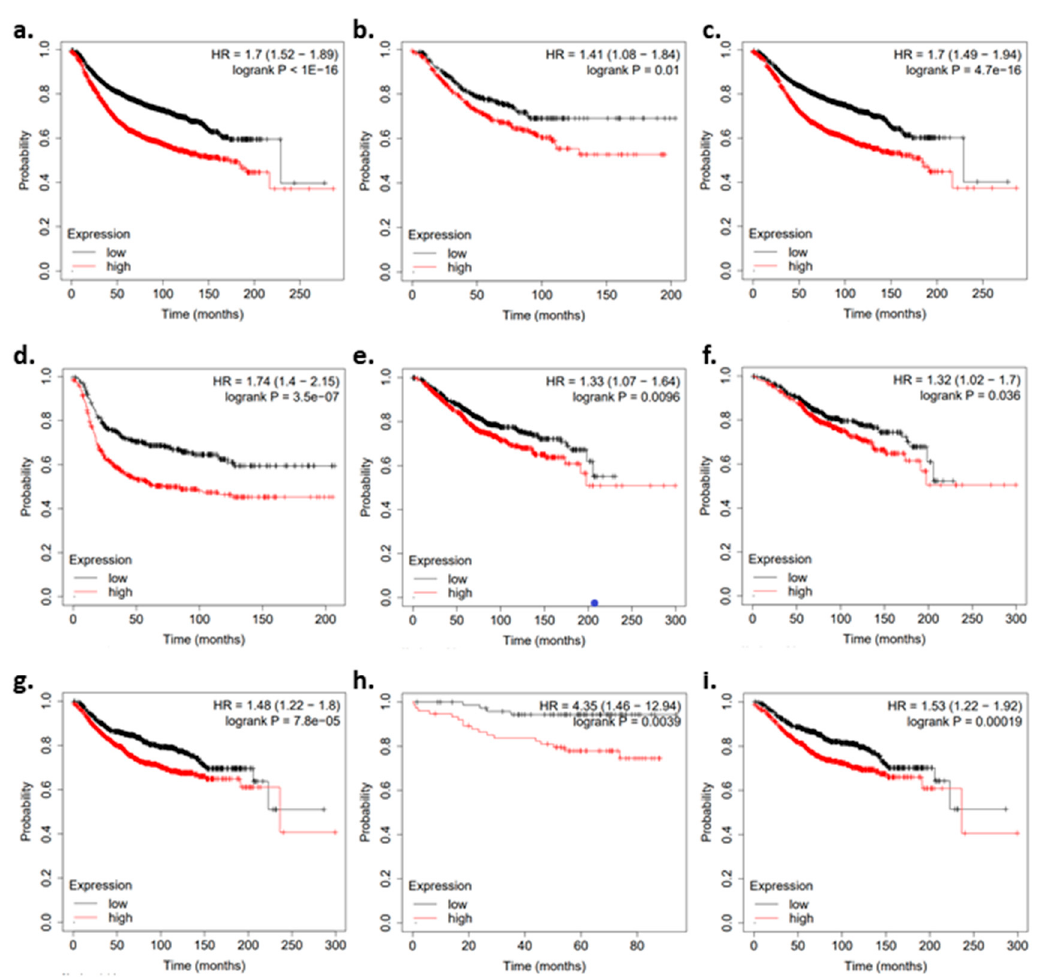
Figure 5. Kaplan–Meier plots for patient prognosis when divided by ACBD3 mRNA expression. Black data points represent patients whose breast tumors had ACBD3 mRNA expression below the median level. Red data points represent patients whose breast tumors had ACBD3 mRNA expression above the median level. ( a – d ) Relapse-free survival when ACBD3 is high or low for ( a ) breast cancer patient cohort overall, ( b ) HER2 − breast cancer patients, ( c ) ER+ breast cancer patients, ( d ) ER − breast cancer patients. ( e , f ) Overall survival when tumor ACBD3 is high or low for ( e ) the breast cancer patient cohort overall, ( f ) ER+ breast cancer patients. ( g – i ) Overall distant metastasis-free survival when tumor ACBD3 was high or low for ( g ) the breast cancer patient cohort overall, ( h ) HER2 − breast cancer patients, ( i ) ER+ breast cancer patients.